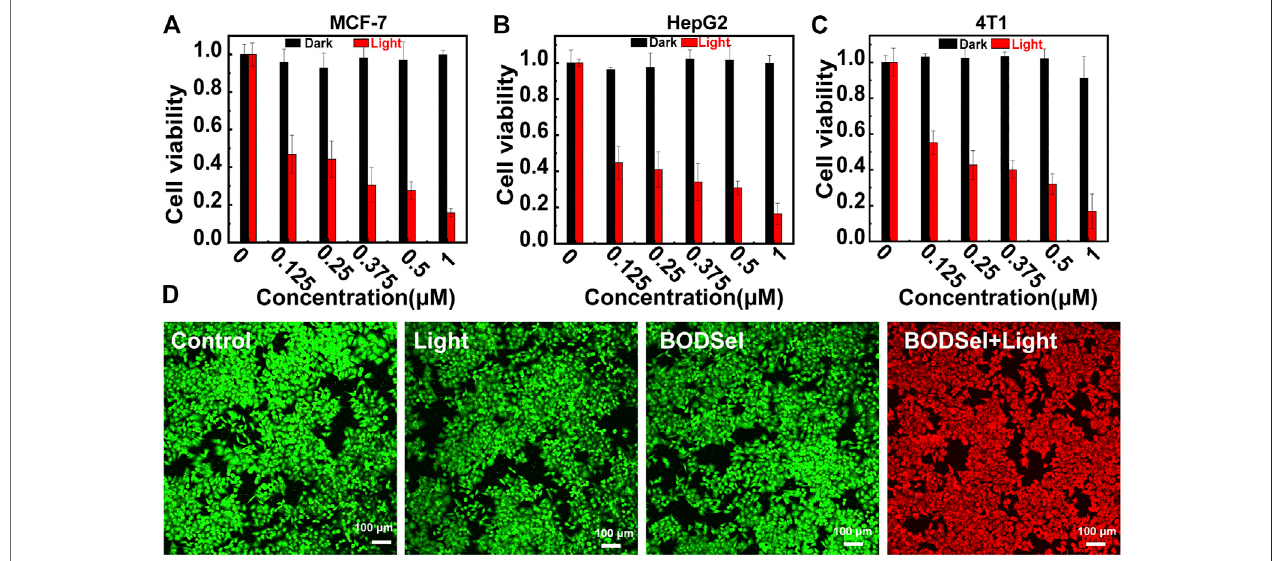
FIGURE 5 | Cell viability of MCF-7 (A) , HepG-2 (B) , and 4T1 (C) cells incubated with different concentrations of BODSeI with or without light irradiation (550 nm, 20 mW/cm 2 , 10 min). (D) Live – dead cell staining with calcein-AM (green) and propidium iodine (red) after different treatments. Green light irradiation (550 nm, 20 mw/ cm 2 , 10 min) was conducted after the cell was incubated with BODSeI (1 μ M) for 30